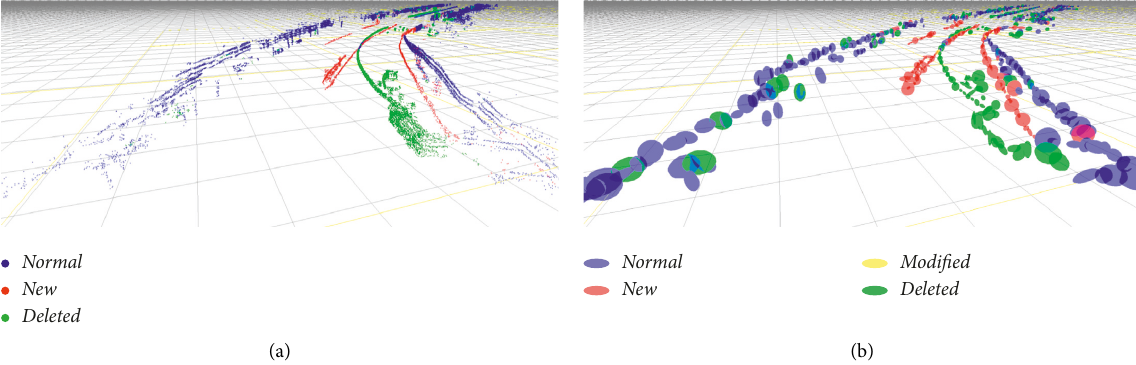
Figure 21: The framework of PCD map update constructed (a) the updated PCD map. The map was converted to (b) the updated GND map.